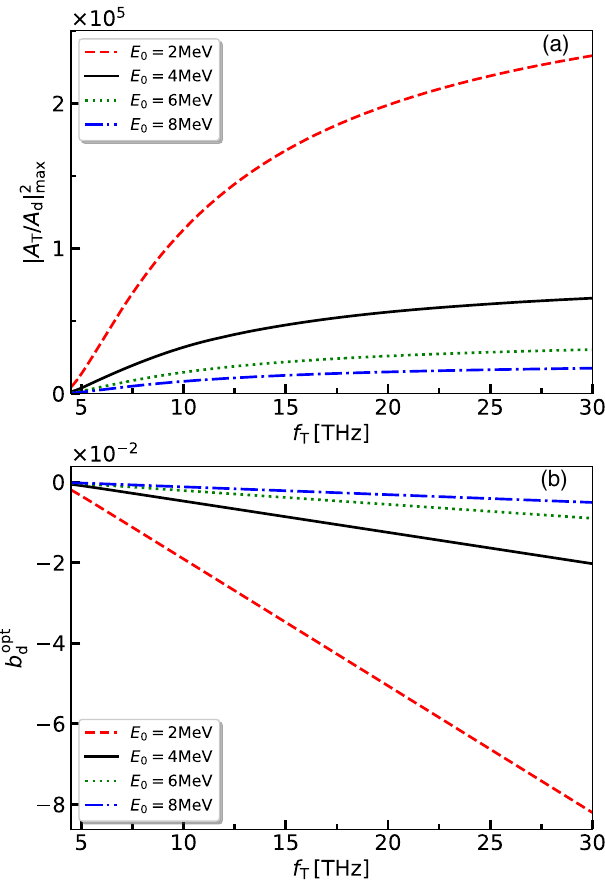
FIG. 5. Terahertz amplification gain (a), and the optimum frequency chirp parameter of the driver wave (b) versus fre- quency for different electron beam energies. All parameters are the same as in Table